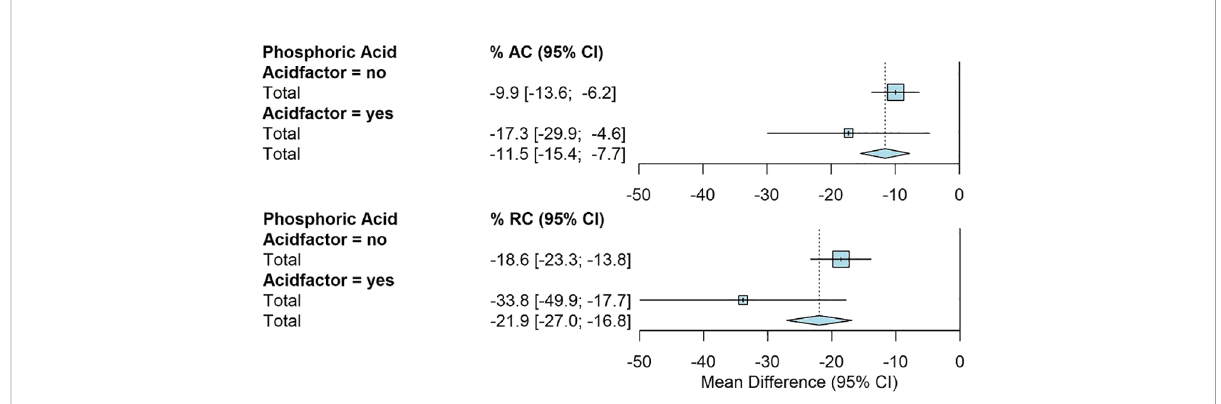
FIGURE 5 Fully random effects forest plot for AC and RC by acid factor. Squares represent average treatment effect for each subgroup with error bars denoting the 95% CI. Diamonds represent the 95% CI of the overall treatment effects.